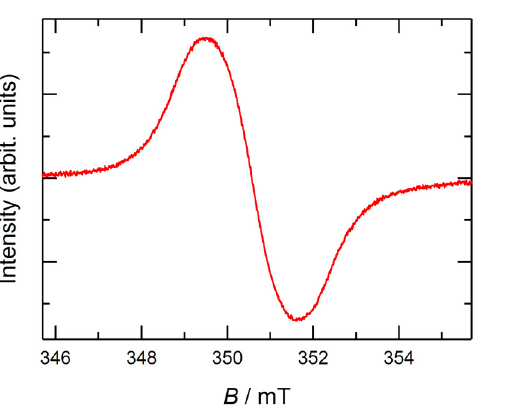
Figure 1. ( a ) X-Band ESR spectrum of iPr 3 BPBN in a toluene solution measured at room temperature. ( b ) Experimental (red) and simulated (blue) ESR spectra of a poly(vinyl chloride) dispersion film containing 1 w/w% of iPr 3 BPBN , measured at 292 K. Relatively sharp signals around 350 mT are ascribable to monoradical impurity. The inset shows a | ∆ m S | = 2 forbidden signal at a half magnetic field.